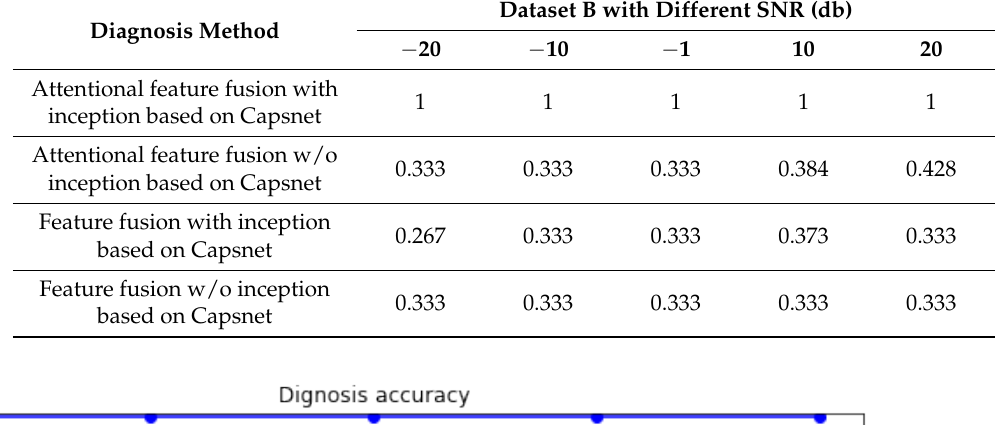
Table 6. The diagnosis accuracy of four feature fusion diagnosis models on different SNR datasets.